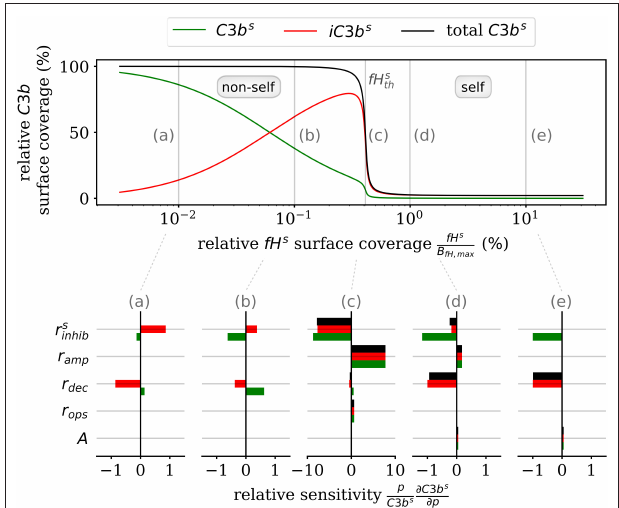
FIGURE 5 | Sensitivity analysis of the model parameters for the steady state of surface-bound C3b molecules. The upper plot shows the relative concentration of complement molecules on the cell surface. The lower plots for selected Factor H concentrations give the relative local sensitivity of the complement molecules with respect to a parameter p that is individually varied. Positive sensitivities correlate with increasing molecule concentration. The non-self regime is sensitive to the rates r dec and r s inhib (see a,b). The transition region (c) is dominated by r s inhib and r amp and the self-regime is dominated by the parameters A , r dec , r s inhib , and r amp (see